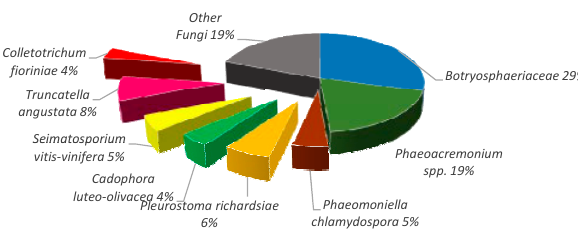
Figure 1. Isolation frequencies of fungal species obtained from symptomatic grapevines during a 10 year survey in the Apulia and Molise regions of